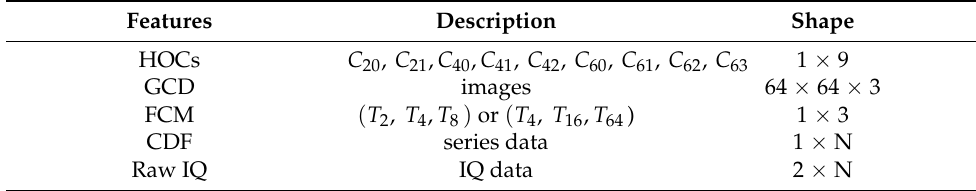
Table 2. The formats of different features for AMC.